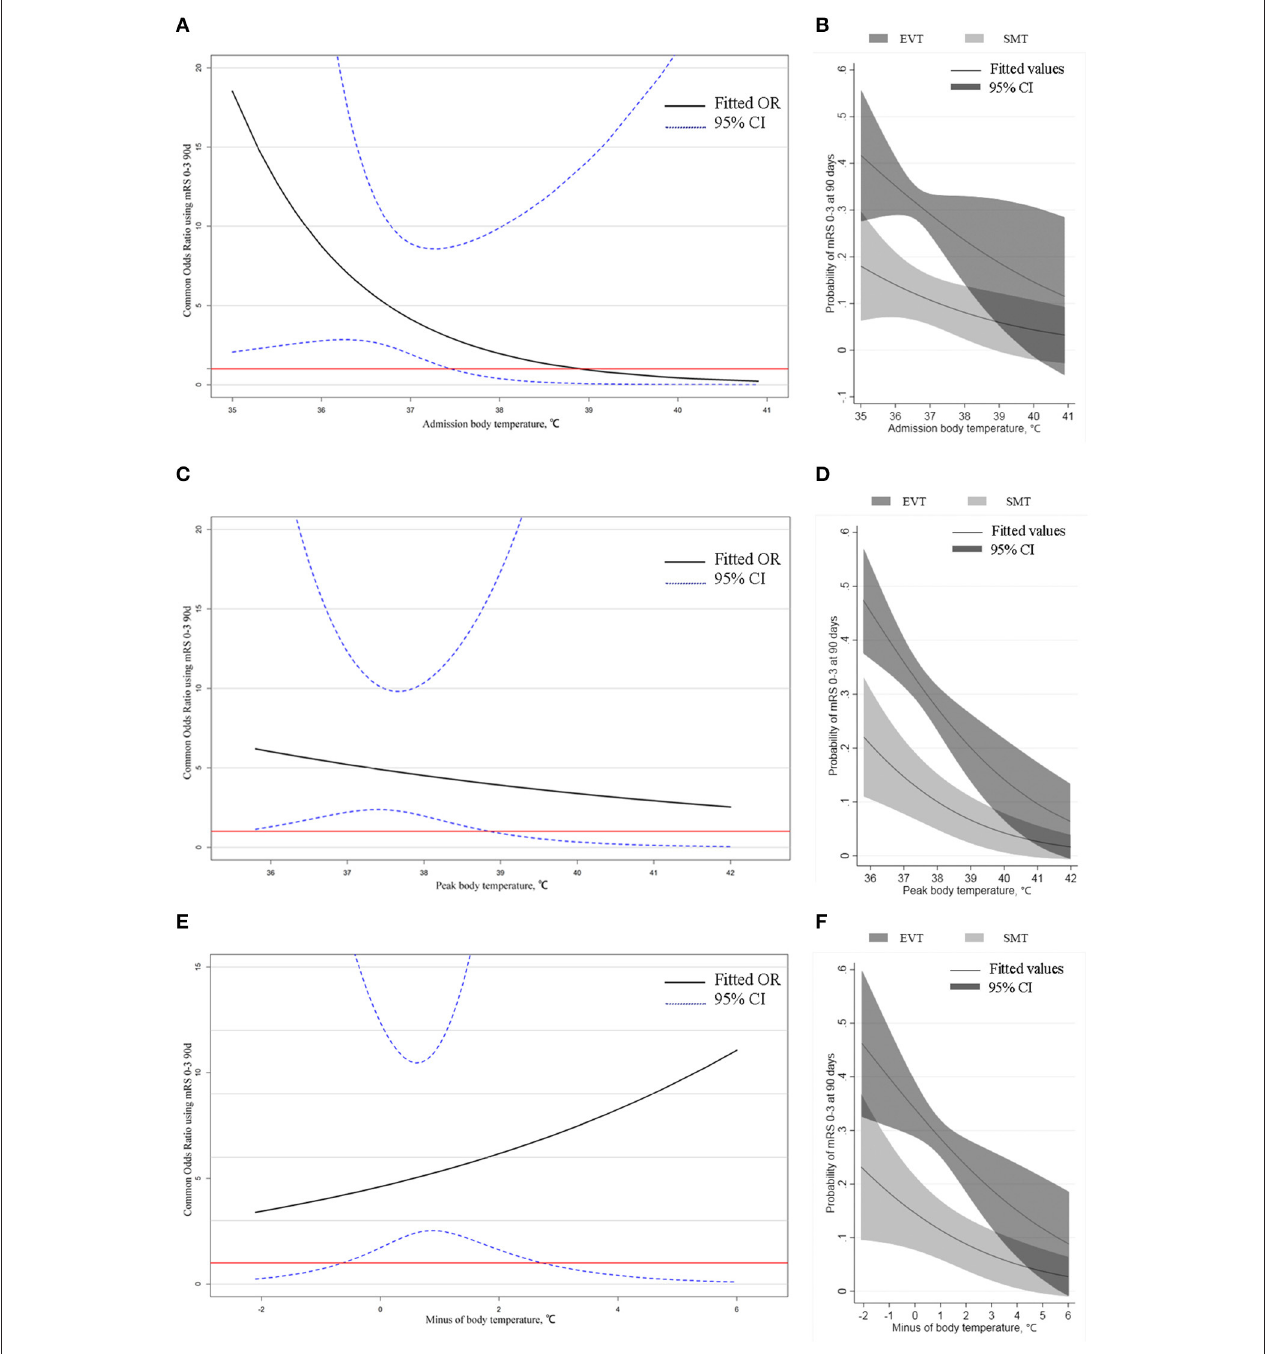
FIGURE 1 | Odds ratio mRS 0–3 90 days in EVT vs. SMT by body temperature in all patients and predicted probability of favorable outcome by body temperature. (A,C,E) Odds ratio mRS 0–3 90 days in EVT vs. SMT by admission body temperature, peak body temperature, and minus body temperature. In all images, the threshold indicates the intersection of the lower limit of the confidence interval with the red line, and the part above the threshold indicates that the benefit of the EVT group is clearly greater than that of the SMT. (B,D,F) Curves showed that the probability of a favorable outcome decreases with increasing body temperature in all three categories, and the probability of a favorable outcome is determined to be higher in the EVT group than in the SMT group in the corresponding temperature range, consistent with the results of (A,C,E) .